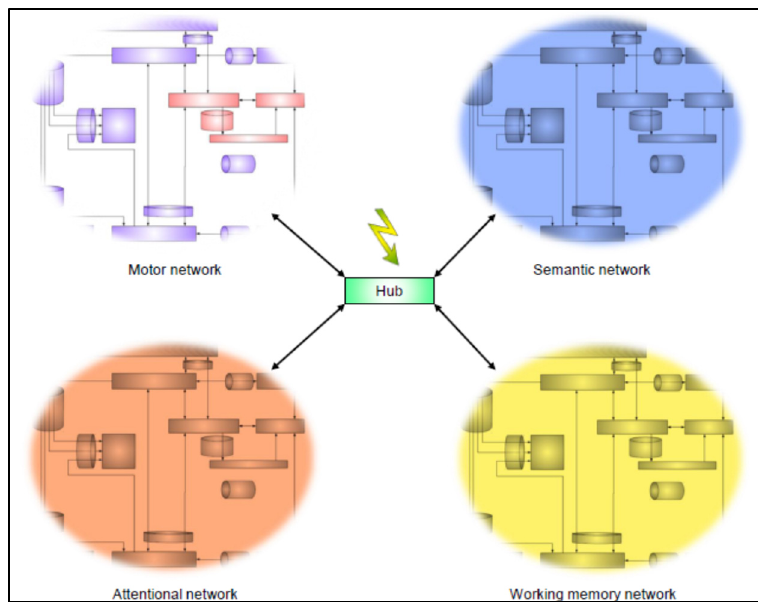
Figure 4. Third level of neural disruption by DES: multitasking. This diagram shows the interplay across the motor network and other neural circuits, in order to illustrate the fact that the system of conation is only part of a large meta-network. Flash represents inter-networks dis-synchronization by stimulating multimodal hub, such as the dorsolateral prefrontal